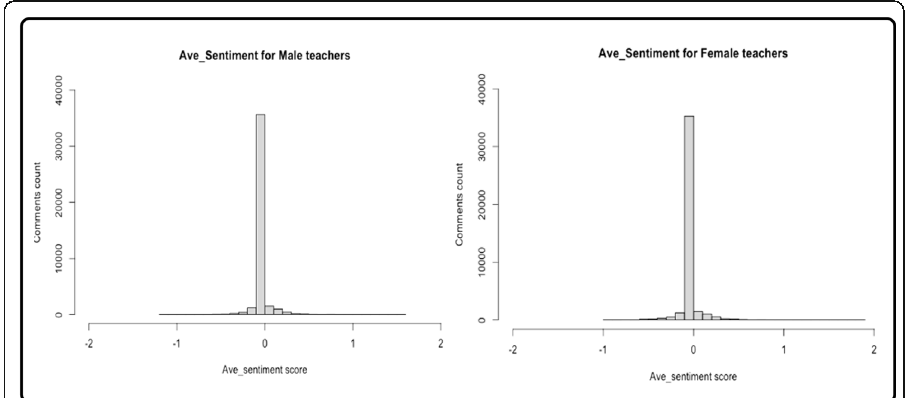
Fig. 4 Number of Comments (counts) vs. Sentiment Score for each